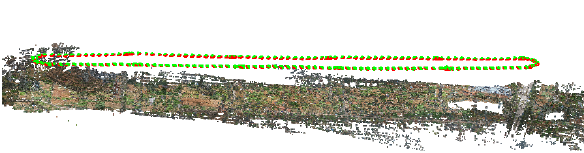
Figure 7. Image orientation of the test site with the assistant of image locations and camera mounting angles.